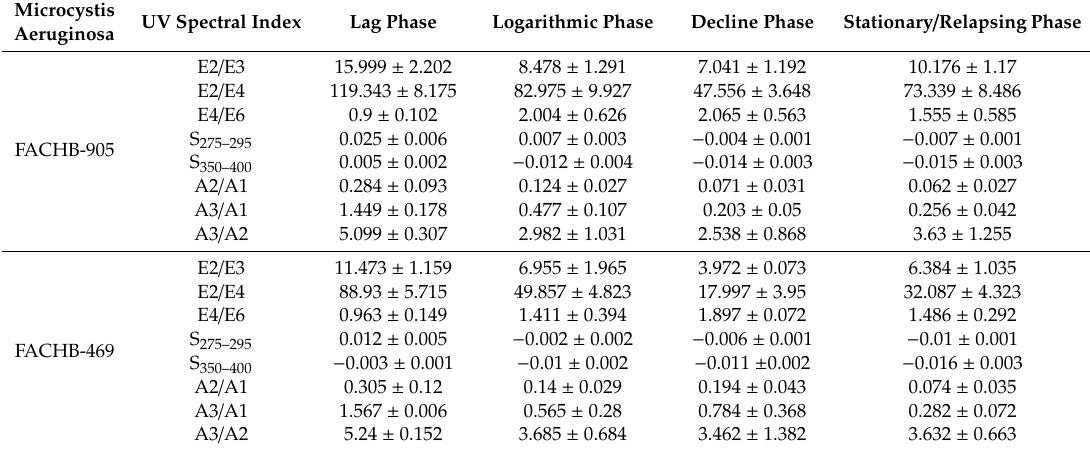
Table 1. Changes in UV spectral characteristics of Freshwater Algae Culture of Hydrobiology